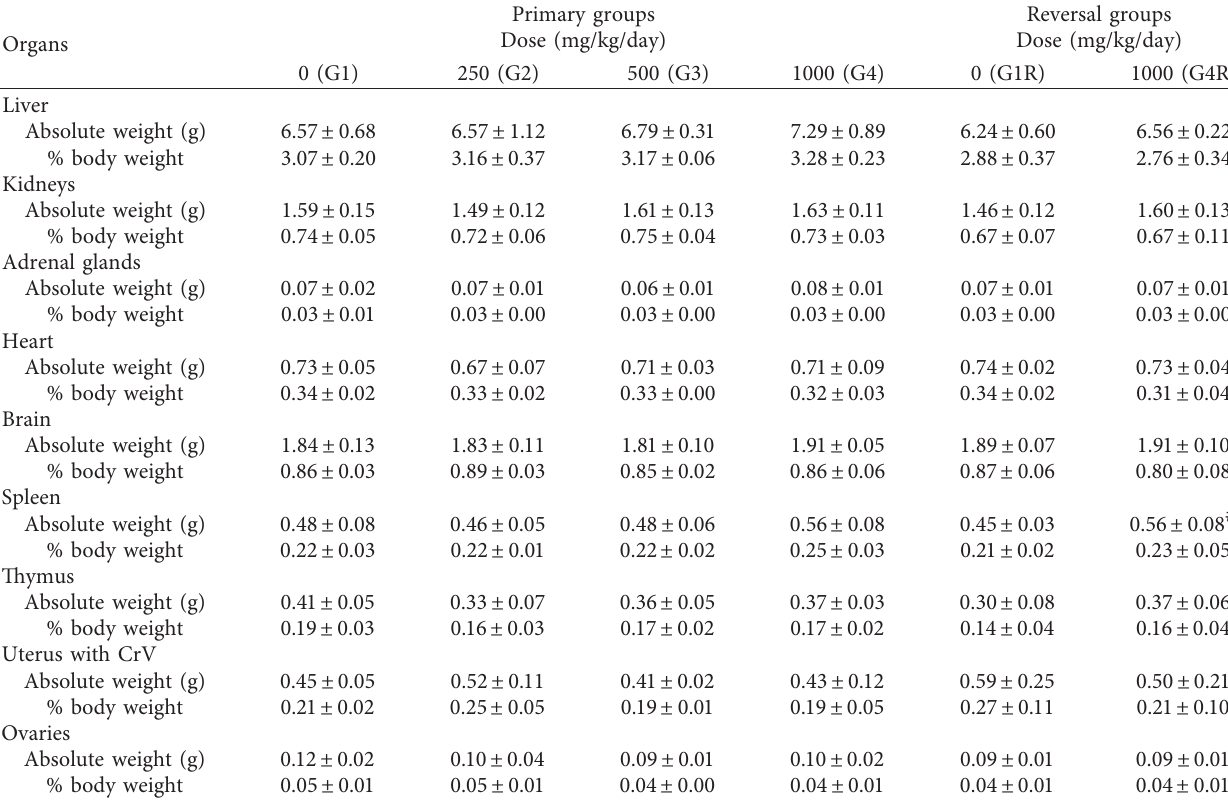
Table 6: Effect of oral administration of GMCT on absolute and relative organ weights of female Wistar rats.